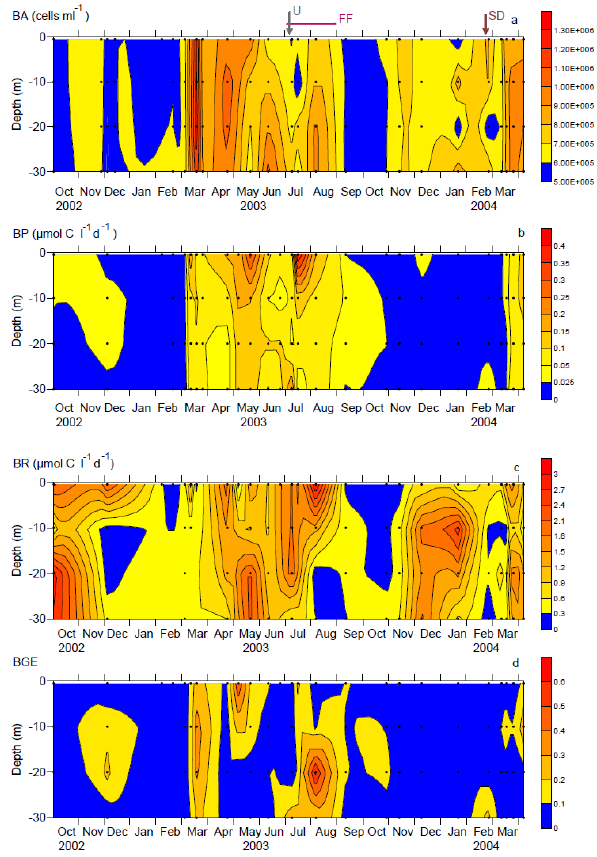
Fig. 9. Changes in bacterial parameters during the study period for the upper 30m of the water column. The dots represent the sampling dates. (a) Bacterial abundance (BA), (b) production (BP), (c) respiration (BR) and (d) growth efficiency (BGE). SD, Sahara dust deposition event, FF, forest fire period; U, upwelling event.